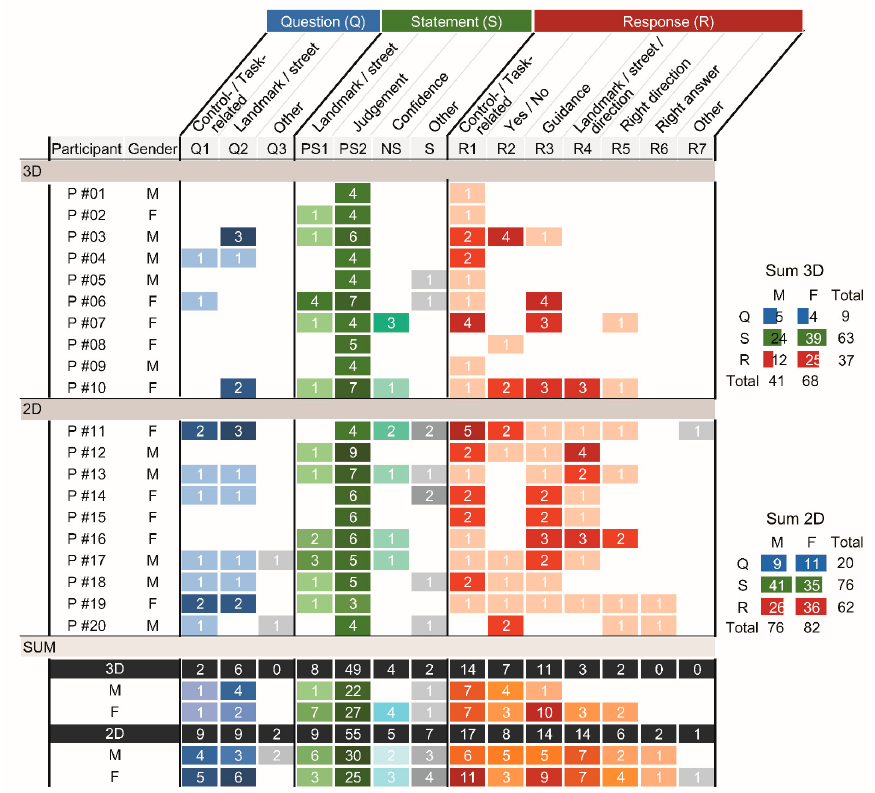
Figure 7. Summary of the verbal protocol. The number on each cell represents the number of occurrences of the corresponding coding category shown in Table 1.